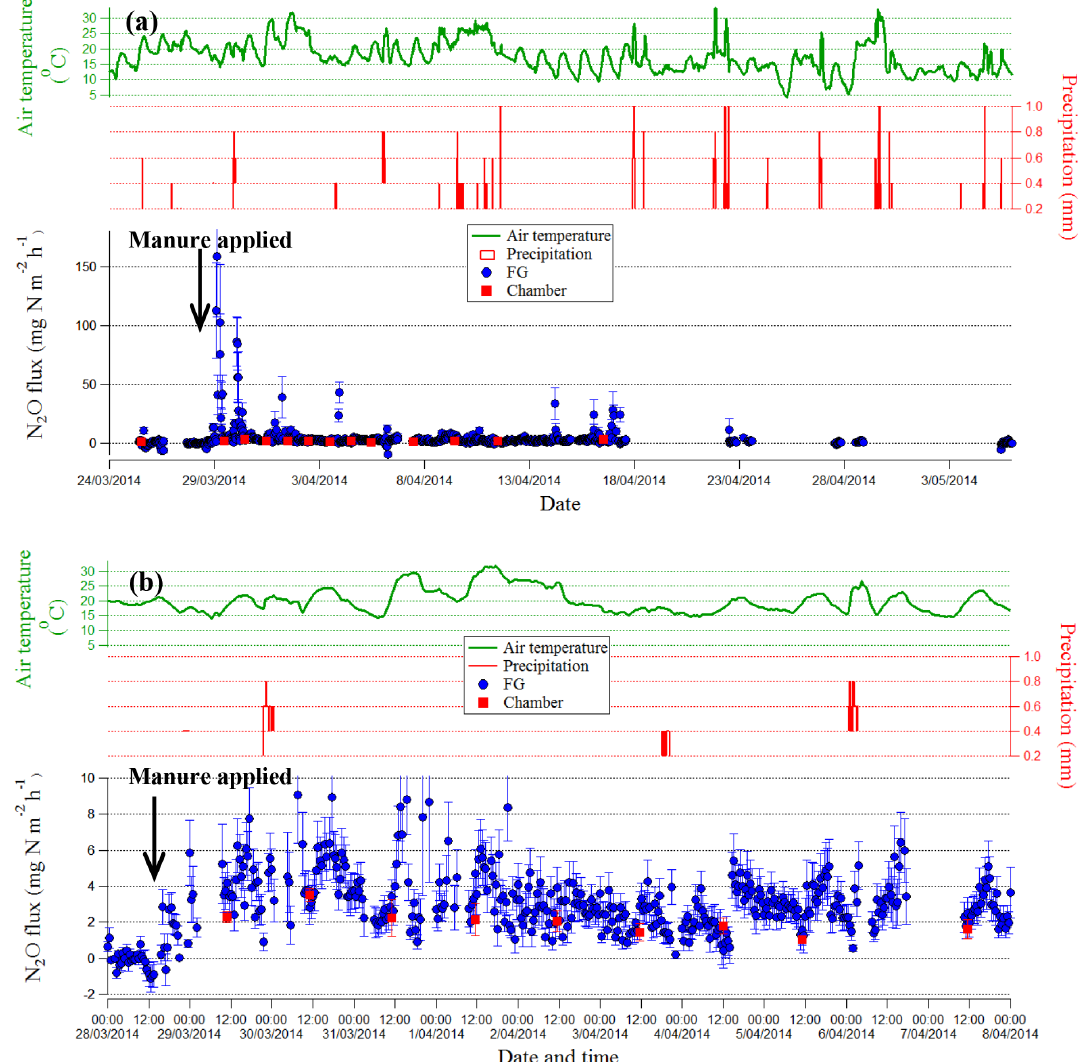
Figure 3. (a) Hourly N 2 O fluxes measured by FG and static chambers from 25 March to 6 May. Air temperature and precipitation are plotted during the same period. (b) Subset of N 2 O fluxes from 28 March to 8 April. Error bars (both upper and lower panels) represent 1 σ estimate of measurement uncertainty ( δ QFG ) for the FG measurements and standard error for chambers. Manure was applied on 28 March